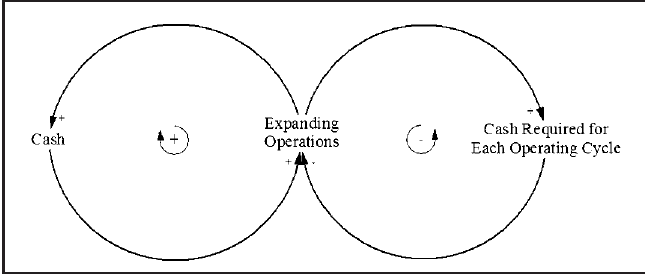
Figure 2. Balancing Feedback Effect on